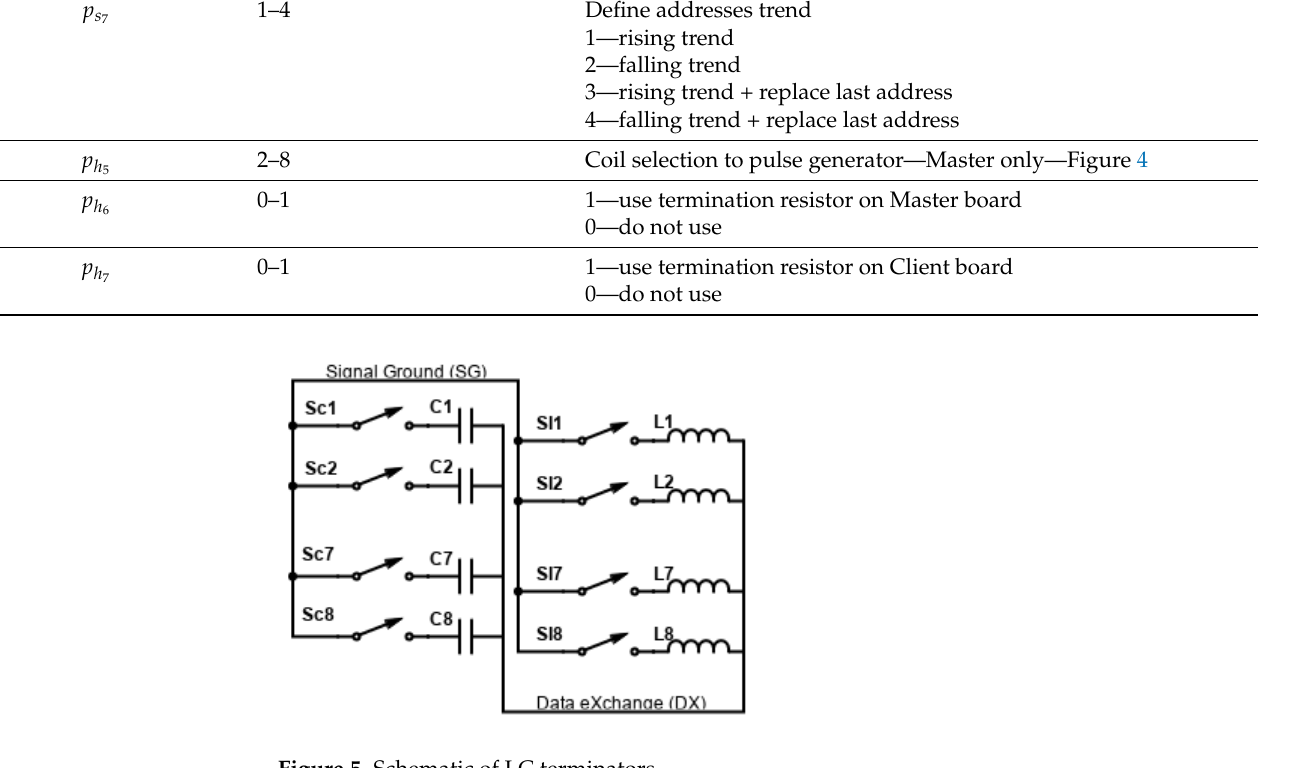
Figure 5. Schematic of LC terminators. Table 3. The 1st